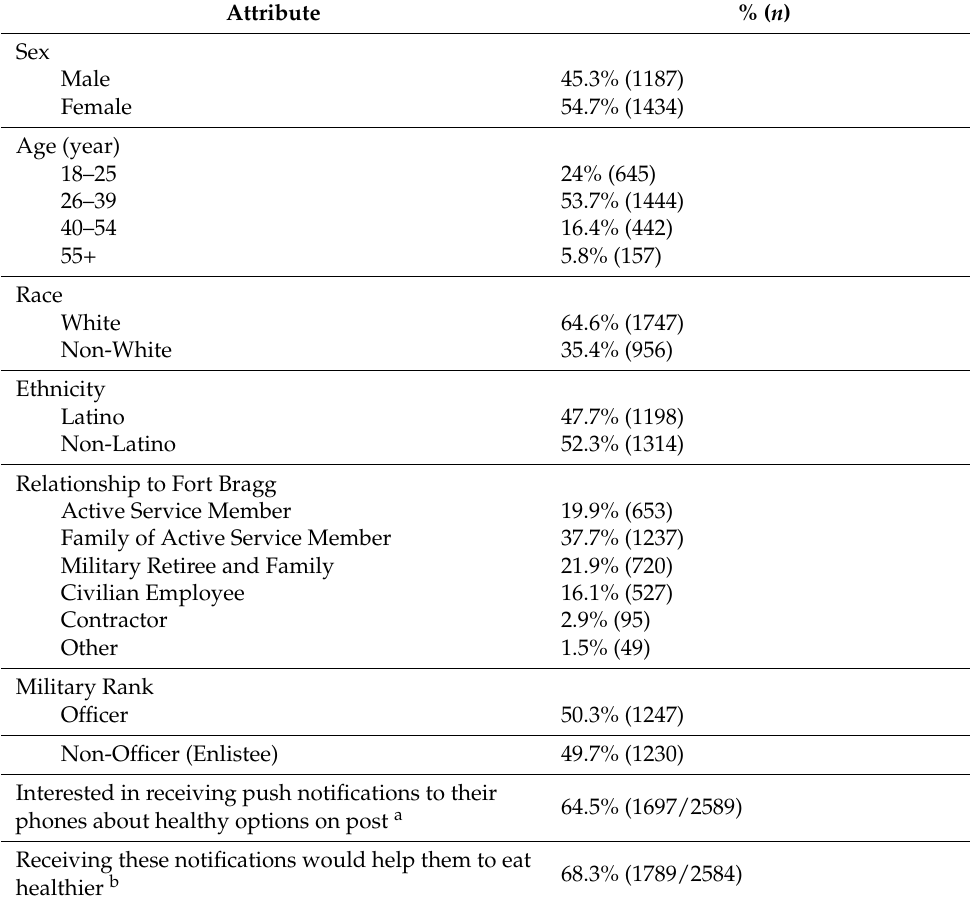
Table 1. Summary of community needs assessment survey participant characteristics and findings regarding interest in receiving push notifications and potential impact on dietary